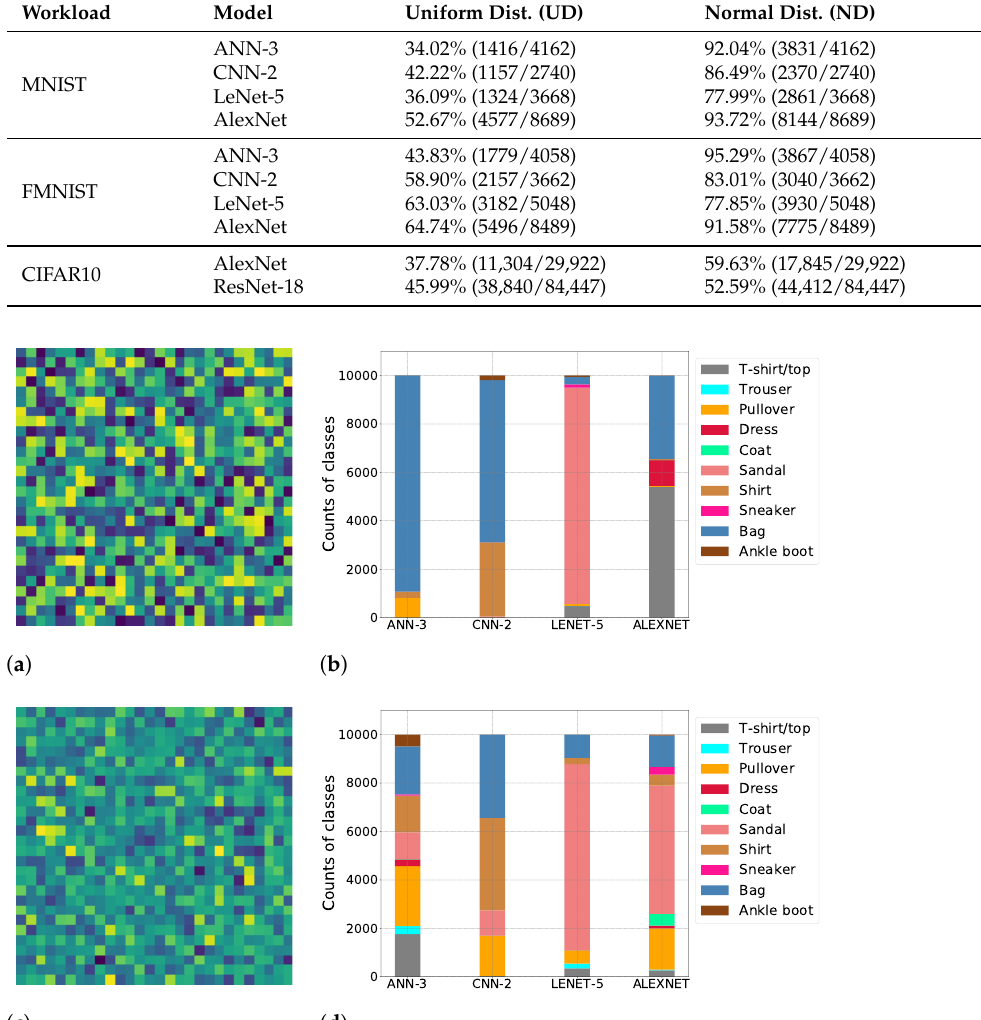
Table 3. Fault coverage achieved by pseudorandom testing for various DNN models.